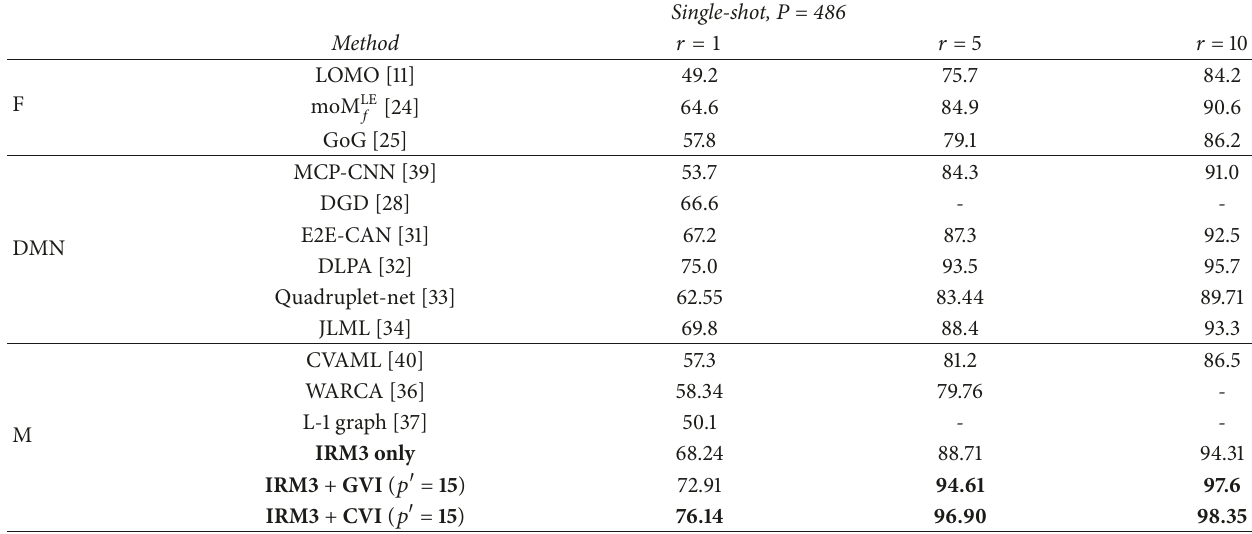
Table 2: Top matching comparison on